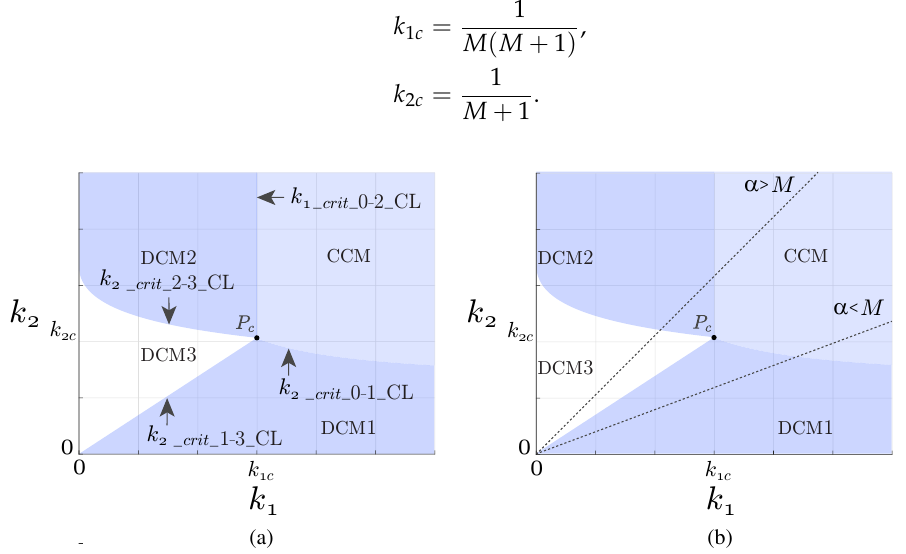
Figure 5. ( a ) Map of conduction regions in closed loops, ( b ) possible